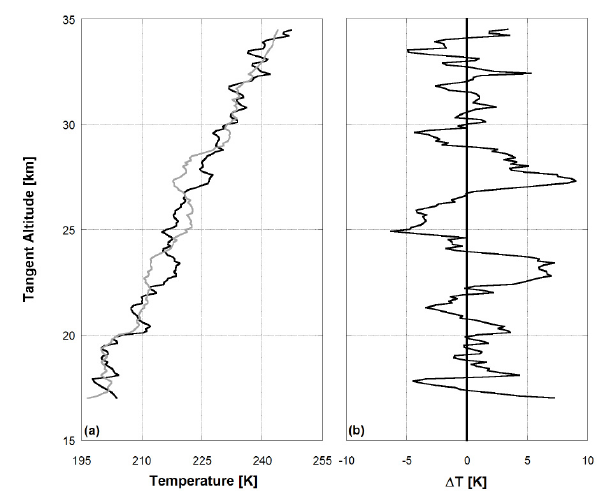
Figure 2. (a) original temperature profiles for GOMOS HRTP (black line) acquired on October 11, 2004, 22:17 LT (10°7’ S, 17°6’ W), for SHADOZ (gray line) measured on the same day at 13:50 LT, above Ascension Island (7°98’ S, 14°4’ W); (b) absolute tem- perature difference between GOMOS and SHADOZ temperature − T . profiles: D T = T GOMOS SHADOZ